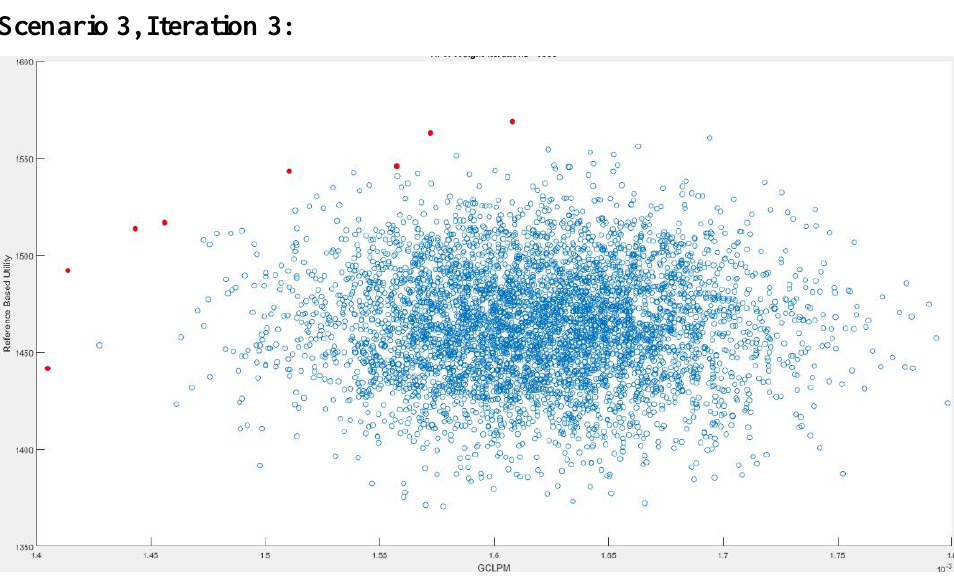
Figure 11. The Result Of Investigation Of 5,000 Different Portfolios In Third Iteration Of Scenario 3